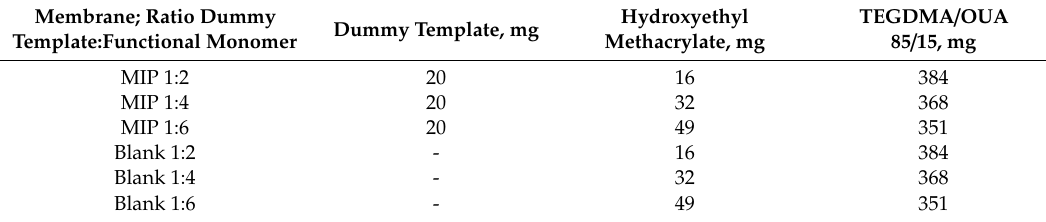
Table 3. Mixture of monomers used for the synthesis of hydroxyethyl methacrylate-containing MIP and blank polymeric membranes capable of zearalenone binding.